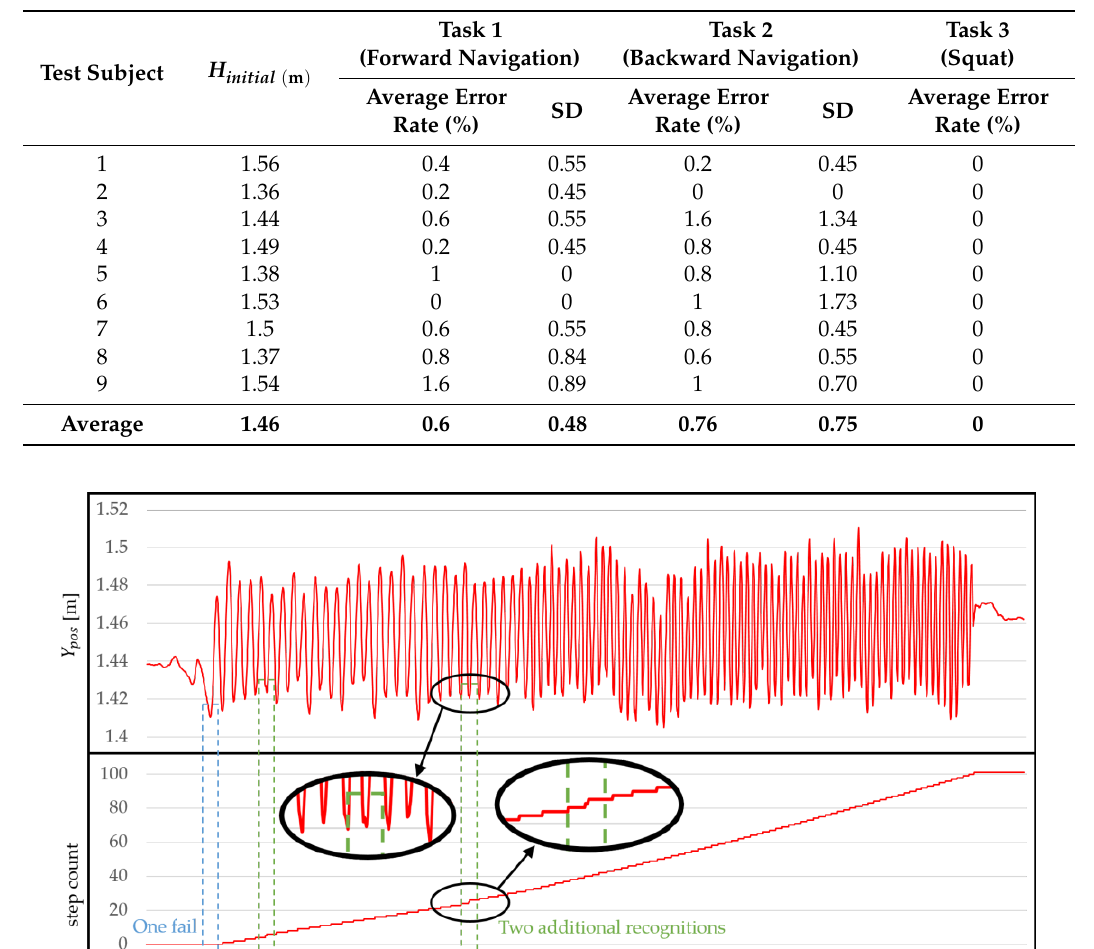
Table 1. The results of the evaluation are shown for nine subjects. The first and second tasks show the average error rate and SD of the five segments, respectively. The third task shows the average error rate for one segment.